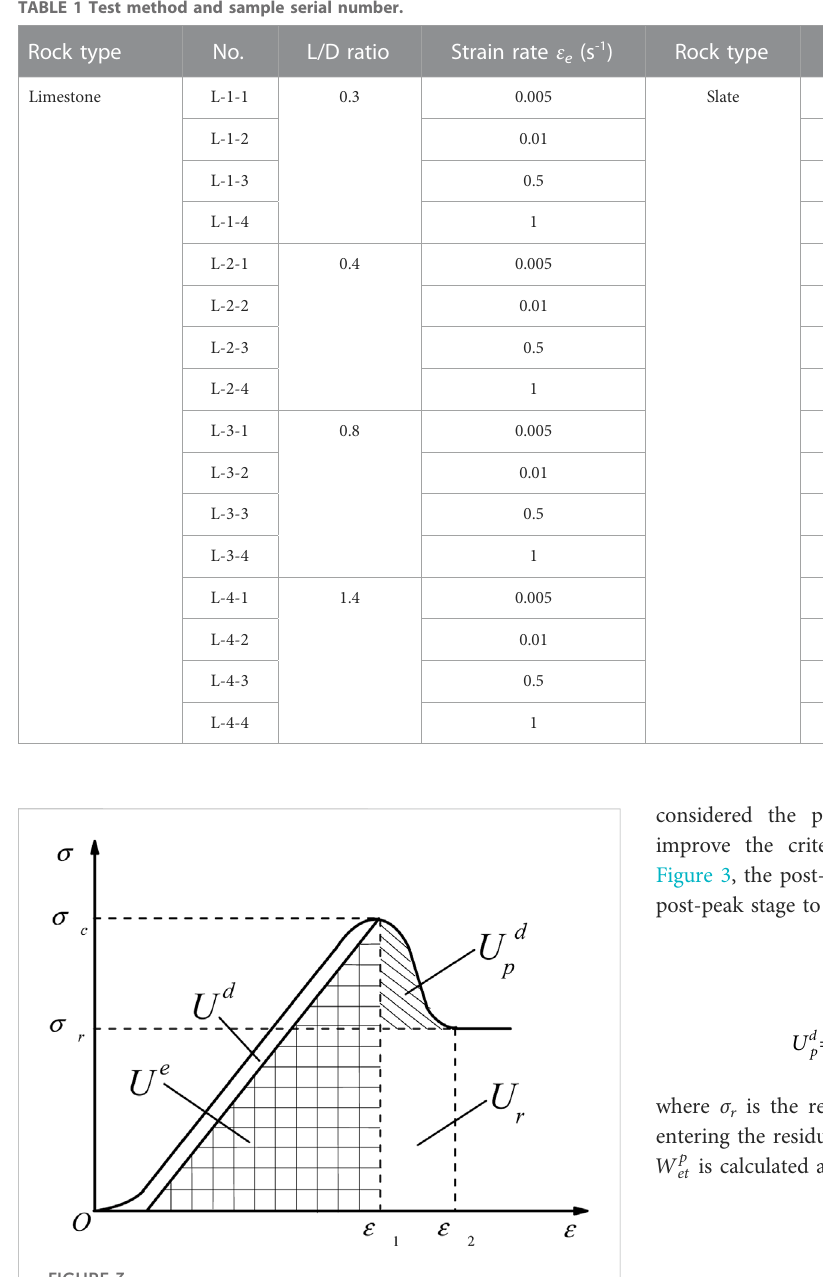
FIGURE 3 Energy evolution and calculation method of the post-peak dissipated energy